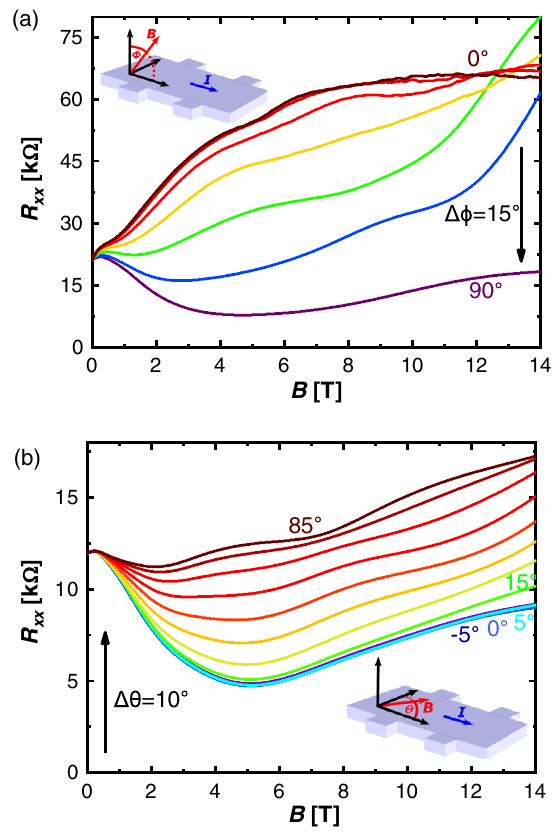
FIG. 5. (a) R xx as a function of the magnetic field B rotated along ϕ from perpendicular to the sample plane towards parallel to the current. In (b), R xx as a function of in-plane rotation with angle θ , where ð θ ¼ 0 ° Þ is parallel to the current and θ ¼ 85 ° nearly perpendicular to the current (inset) at T ¼ 0 . 3